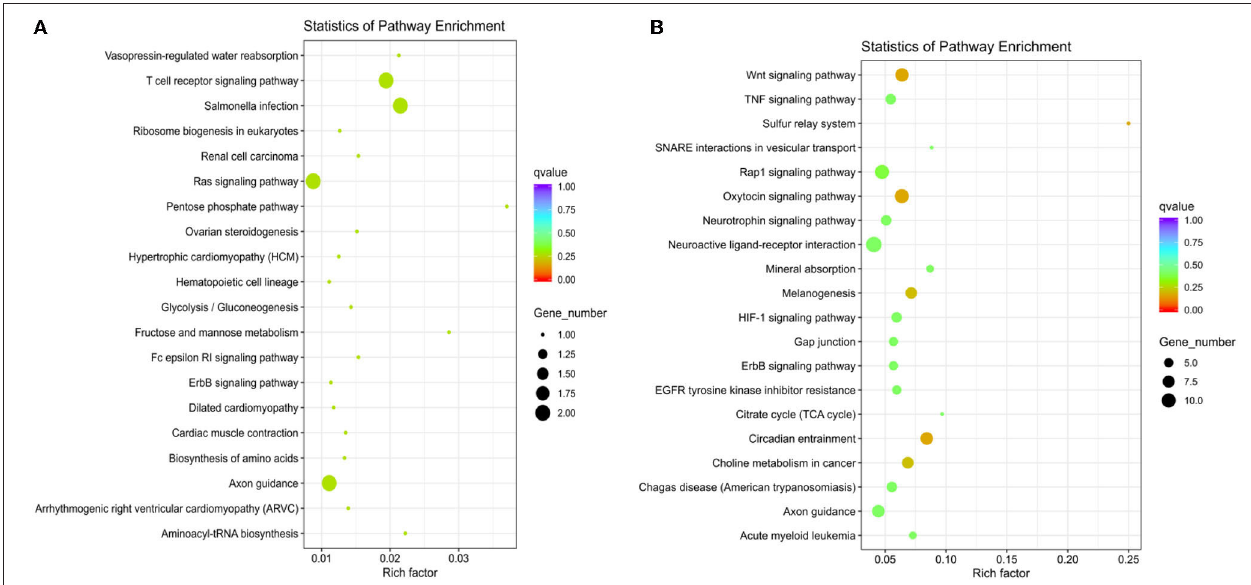
FIGURE 4 | (A) The top KEGG enrichment analyses of the differentially expressed miRNAs in M70 vs. M120. (B) in M120 vs. M90.